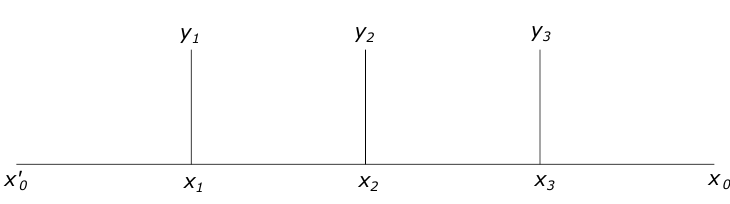
ˆ ( x | y ) = ˇ Q (3) Q (3) i/ 2 , 0 ) − 2 and ( x k − x h